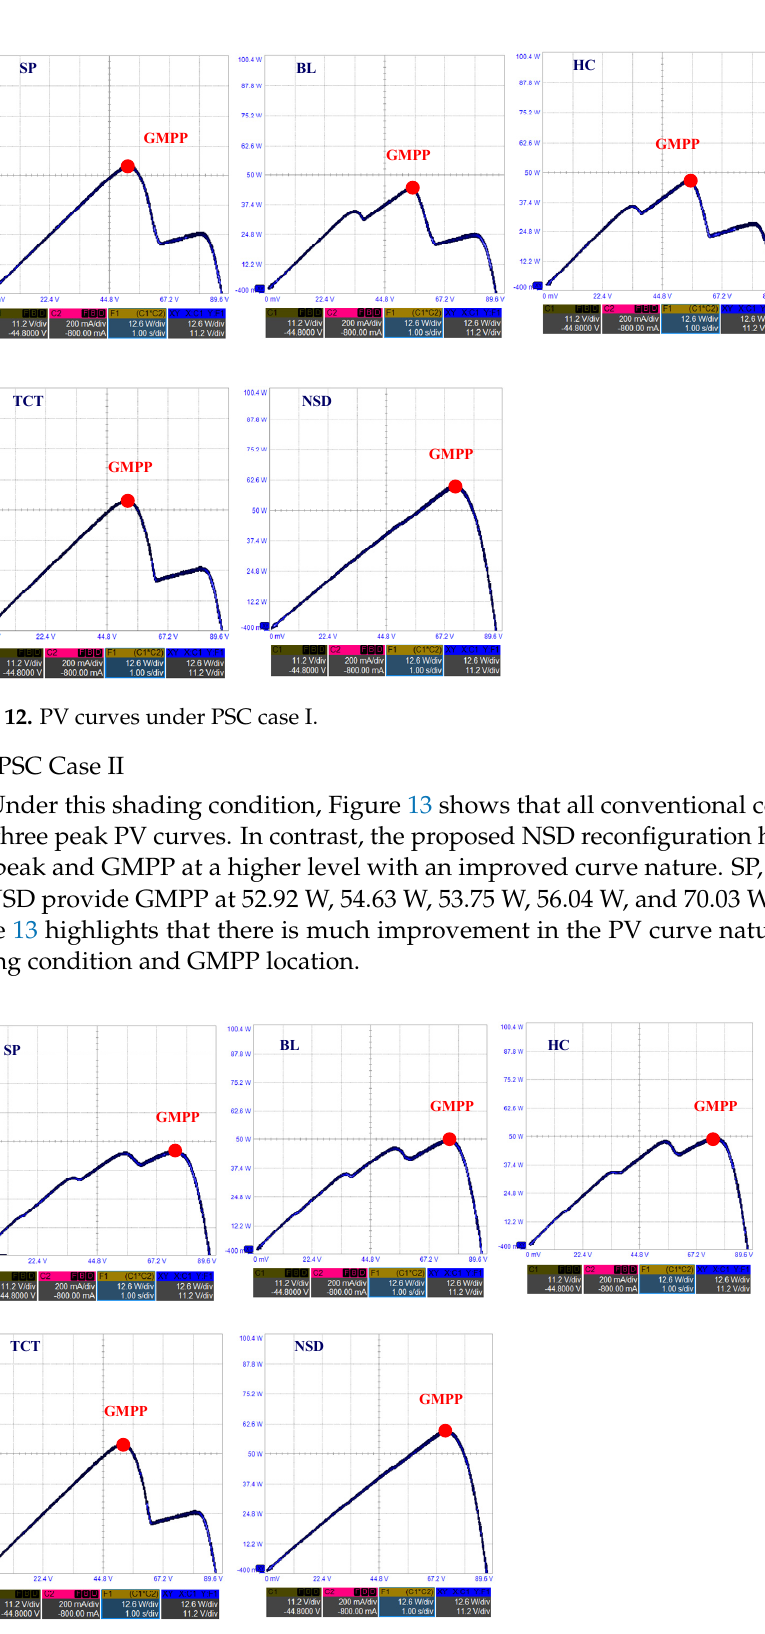
Figure 13. PV curves under PSC case II.